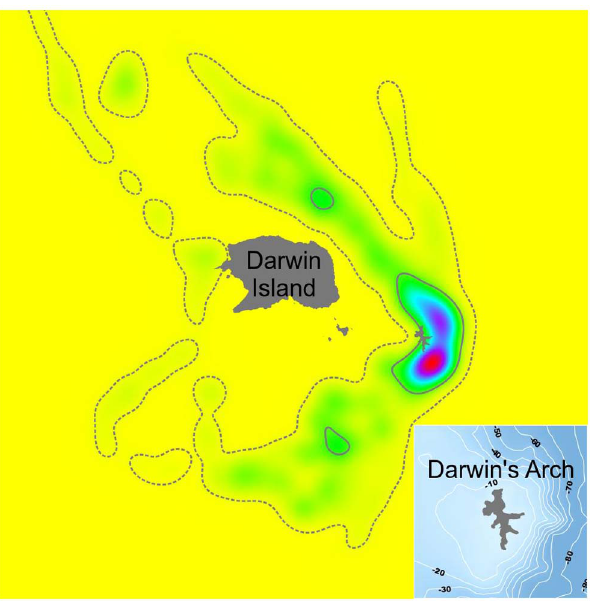
Fig. 6. Kernel Utilization Distribution (UD) of whale sharks at Darwin Island. Kernel density is color coded, with warmer colors indicating highest probabilities and colder colors lower ones (A). Home range deduced from UD with 95% and 50% of probability indicated by dotted and continuous lines, respectively (A). (B) Detail of bathymetry at Darwin’s Arch.